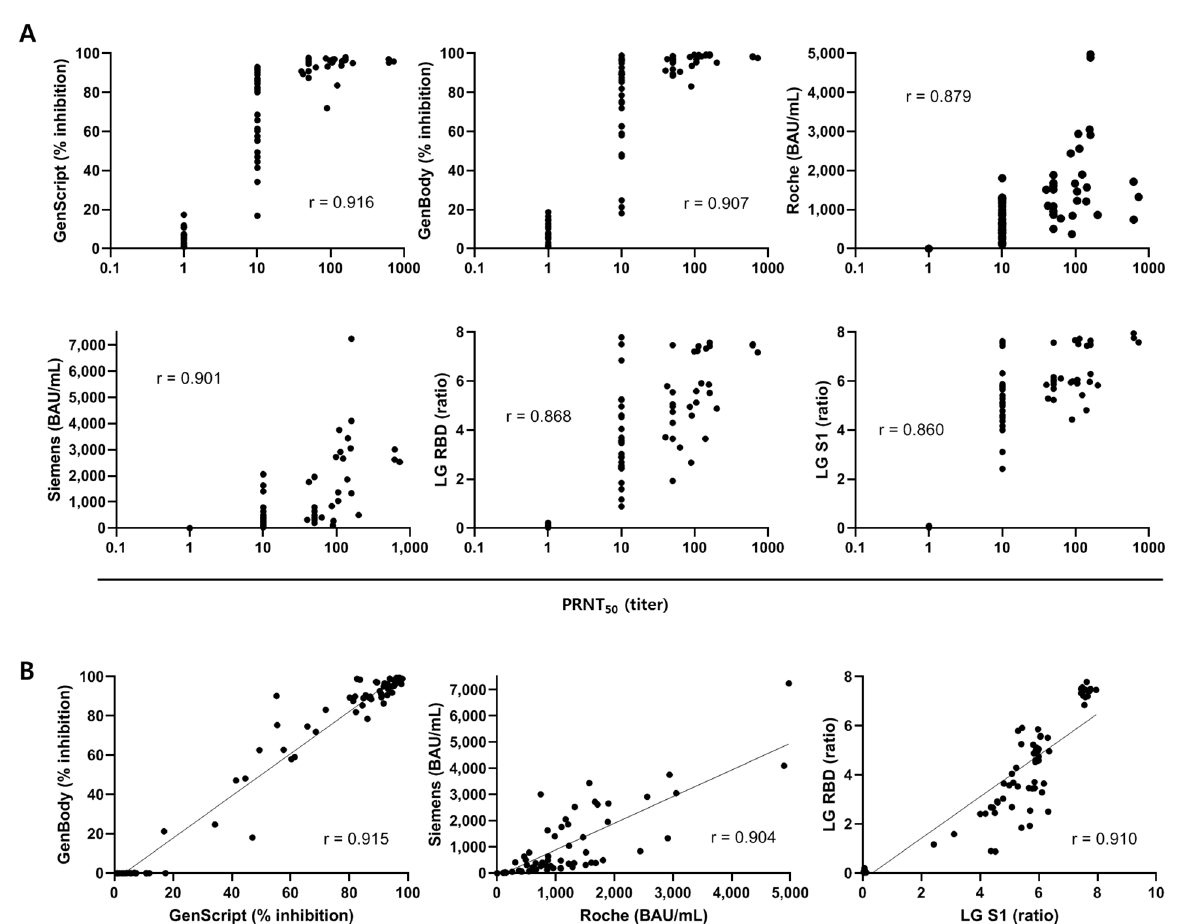
Figure 3. Correlations between antibody results. ( A ) Correlation between antibody levels by SARS- CoV-2 serologic assays (two sVNTs, two CLIAs, and two EIAs) and neutralizing antibody titers by PRNT. ( B ) Correlation between the antibody test results using similar assays (sVNT, CLIA, and EIA). Spearman correlation coefficients ( r ) are displayed.